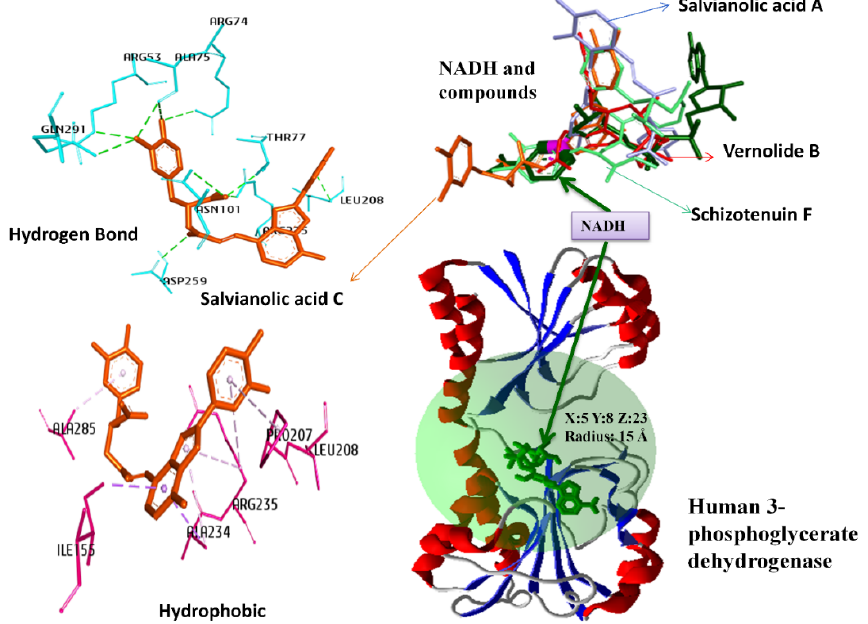
Figure 1. Binding cavities and their details for each molecular docking simulation (The nitrogen of the nicotinamide ring of NAD+ has been marked in pink and bold).